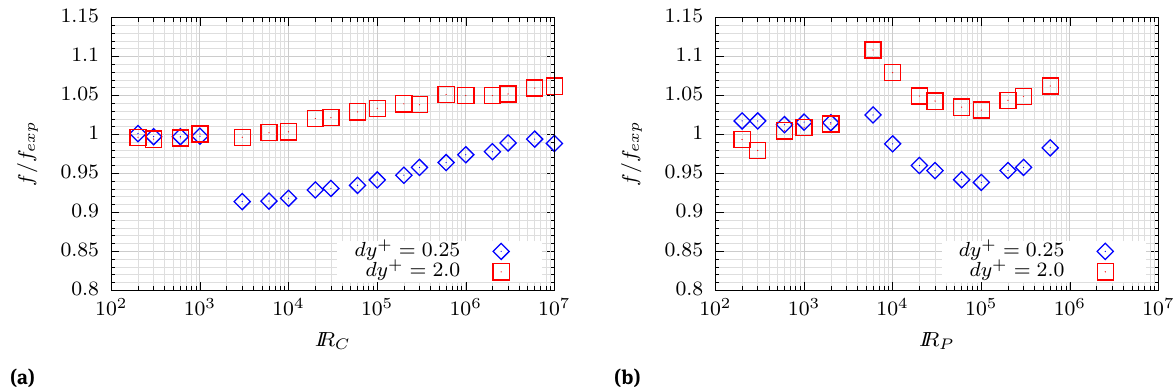
Figure 7: Relative error of friction factor from LRN treatment with coarser mesh for circular pipes (left) and parallel plates (right).